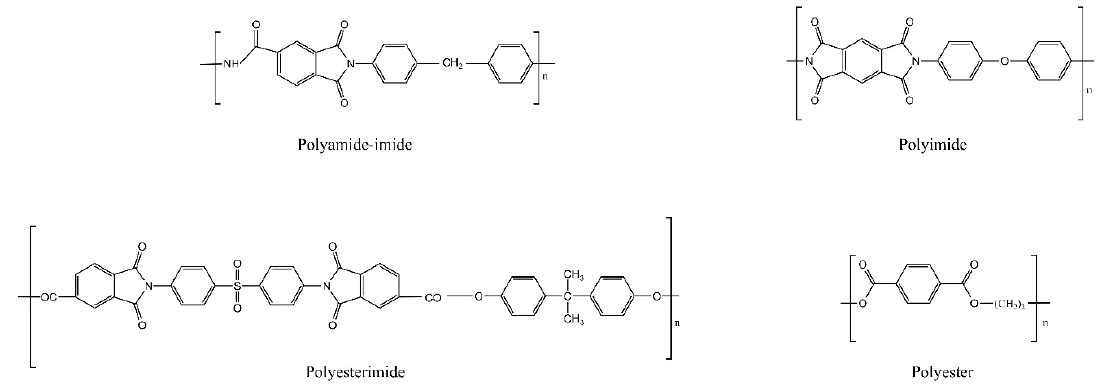
Figure 1. Structural formulas of the four polymers [13–17].